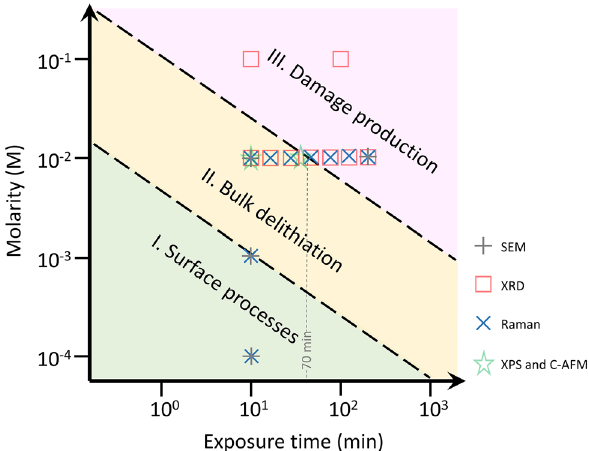
Figure 1. Overview of the different chemical delithiation regimes of LCO thin films with a diluted solution of oxalic acid. Symbols represent the parameters of acid concentration and exposure time that have been used in the experiments. Dashed lines tentatively separate the regions of the parameter space of the different